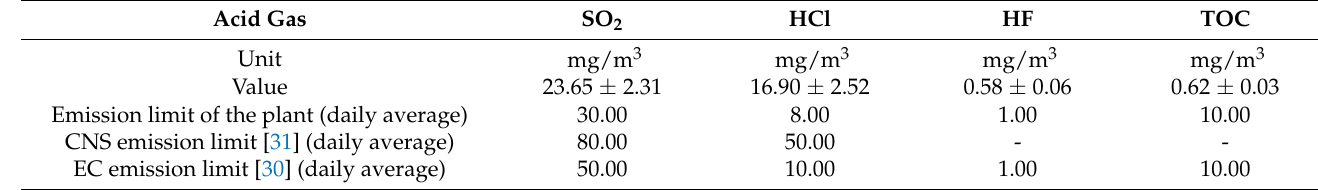
Table 4. The emission concentrations of other acid gases in the flue